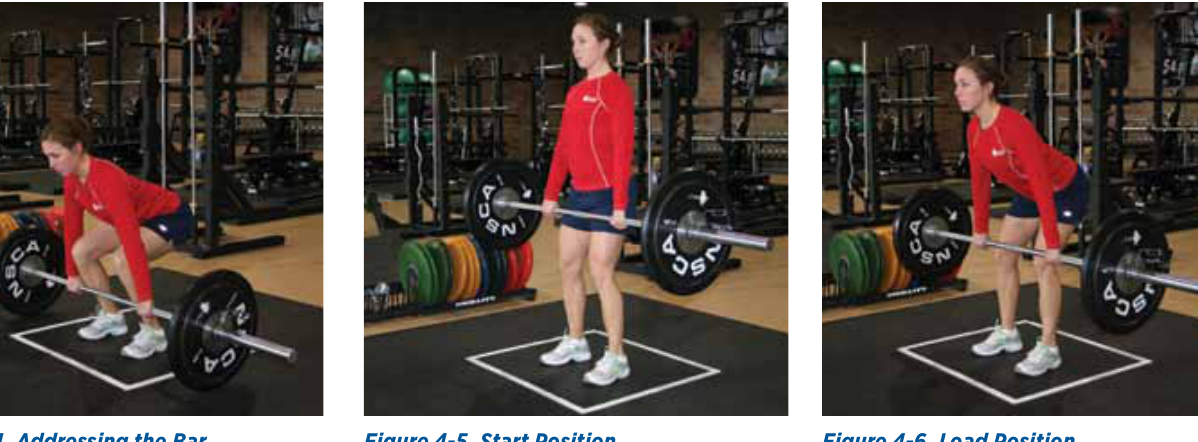
Figure 4-4. Addressing the Bar Figure 4-6. Load Position Figure 4-5. Start Position